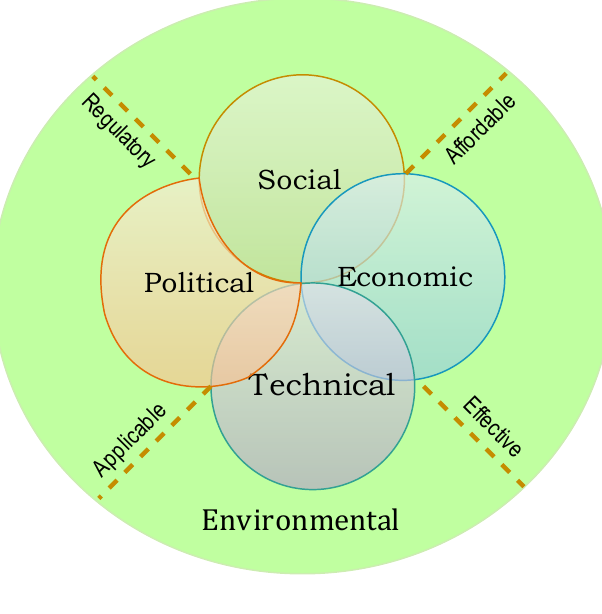
Figure 2. Spheres in a sustainable zero waste